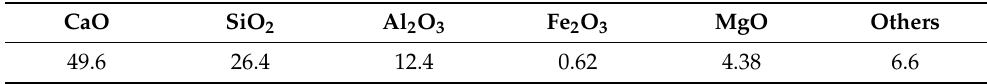
Table 3. Main chemical components of the eco-friendly inorganic binder (powder) (%).